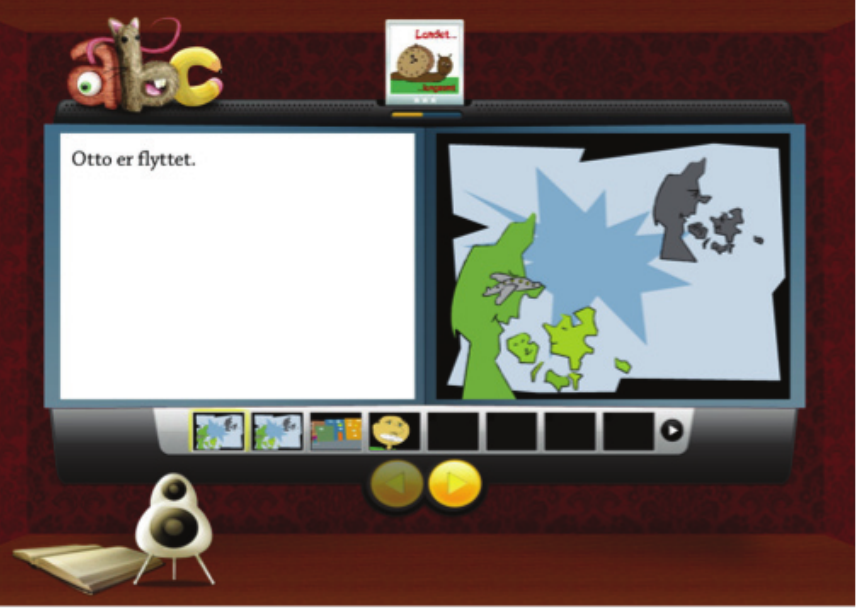
Figure 2: Screen dump from abc.dk